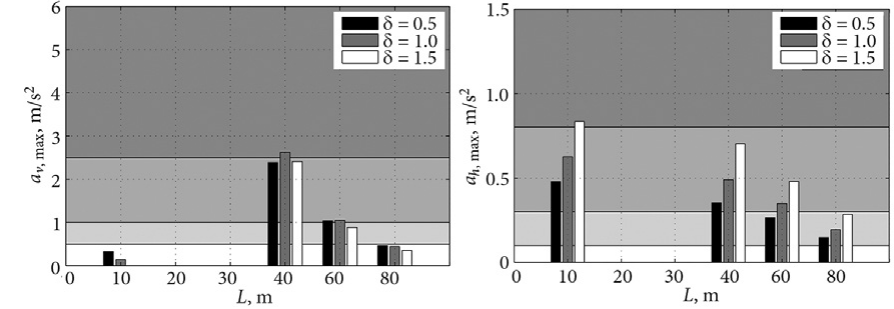
Fig. 15. Vertical and lateral accelerations induced by a flow of walkers: spectral approach of